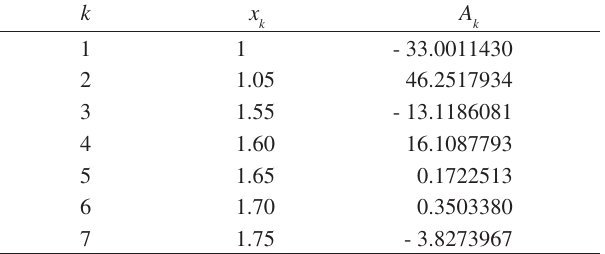
in units of a . k